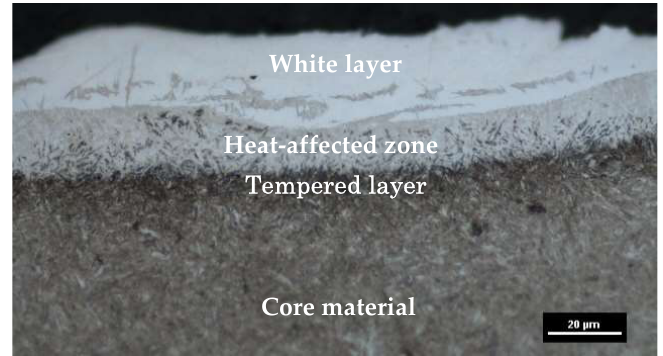
Figure 6. The metallographic structure of tool steel 55NiCrMoV7 after (EDM).